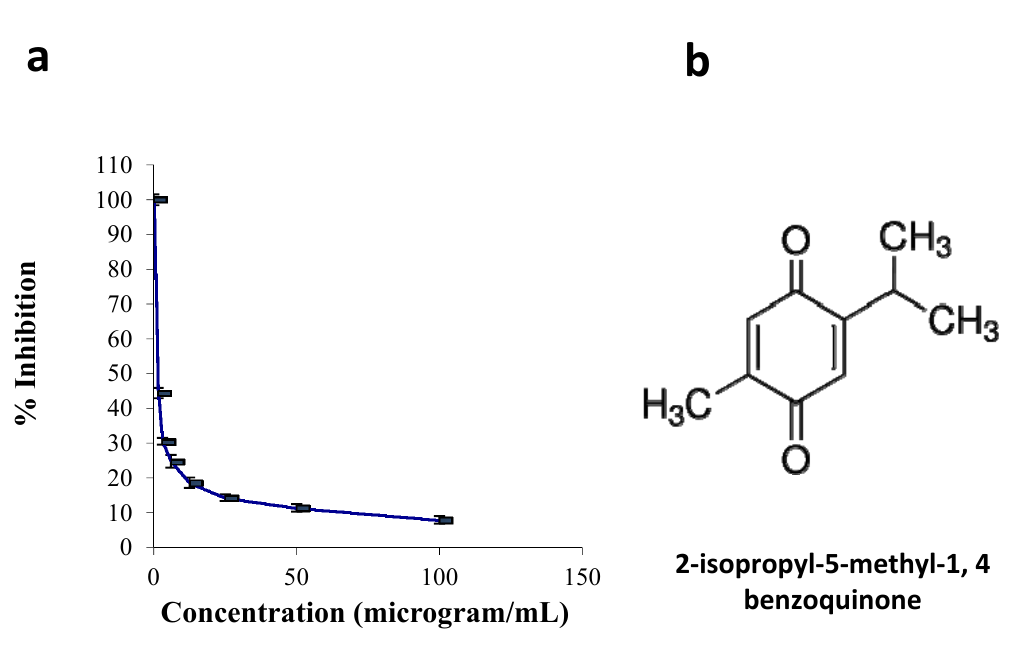
Figure 1. Effects of Thymoquinone on cell viability in CEMss. ( a ) The cell viability of cells after 24 h of treatment. Each point is the mean ± S.D. of three independent experiments. ( b ) The chemical structure of